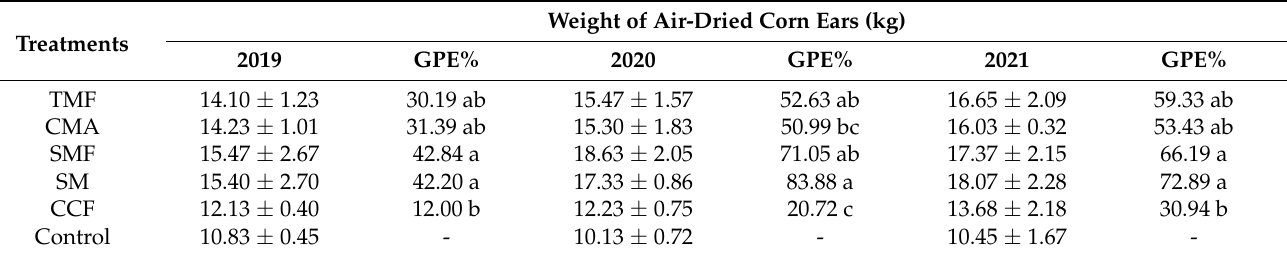
Table 2. Effects of different microbial fertilizers on corn